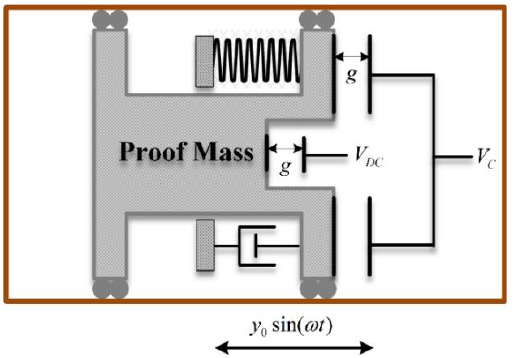
Figure 1. Schematics of the proposed actively tuned capacitive energy harvester .